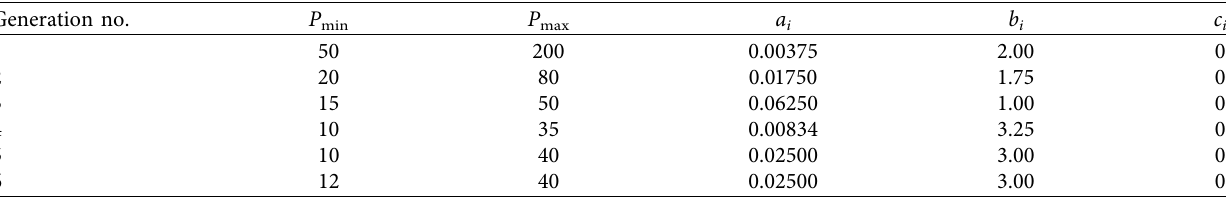
Table 17: Generation data